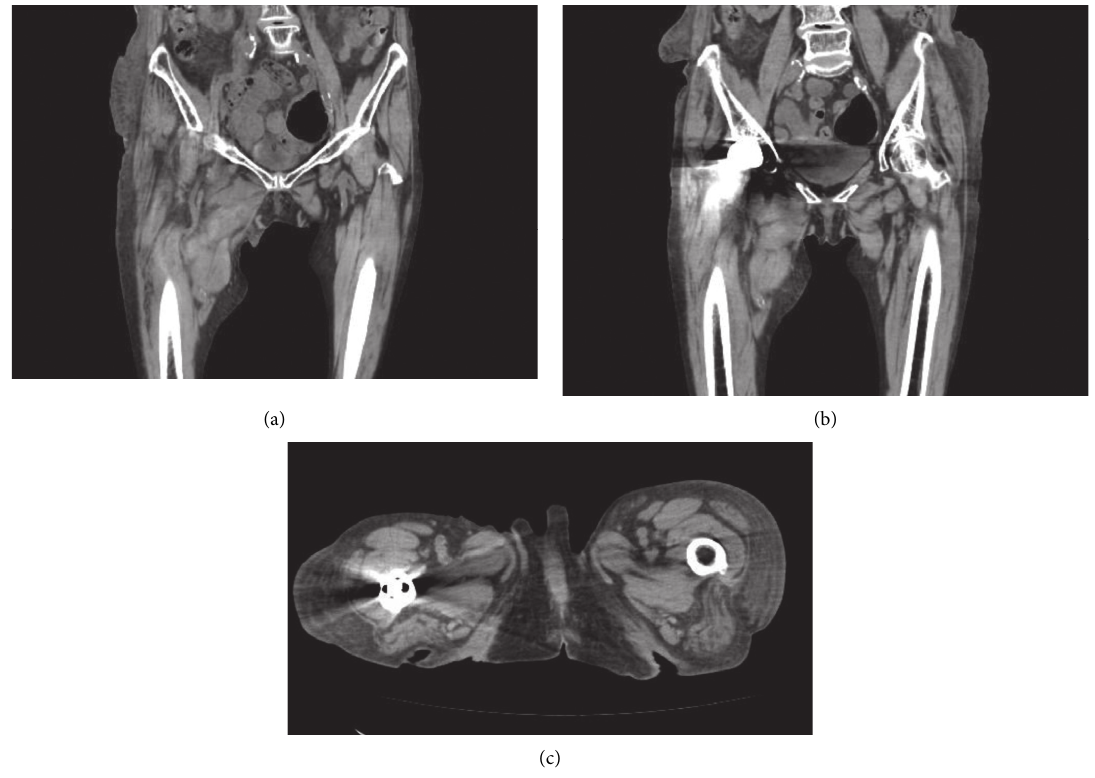
Figure 1: (a) CTon POD 4 showing hematoma spreading from the front of the right pubis to the inner aspect of the thigh. (b) CTon POD 9. Hematoma progression was observed without expansion. (c) CT on POD 53. The hematoma and subcutaneous bleeding